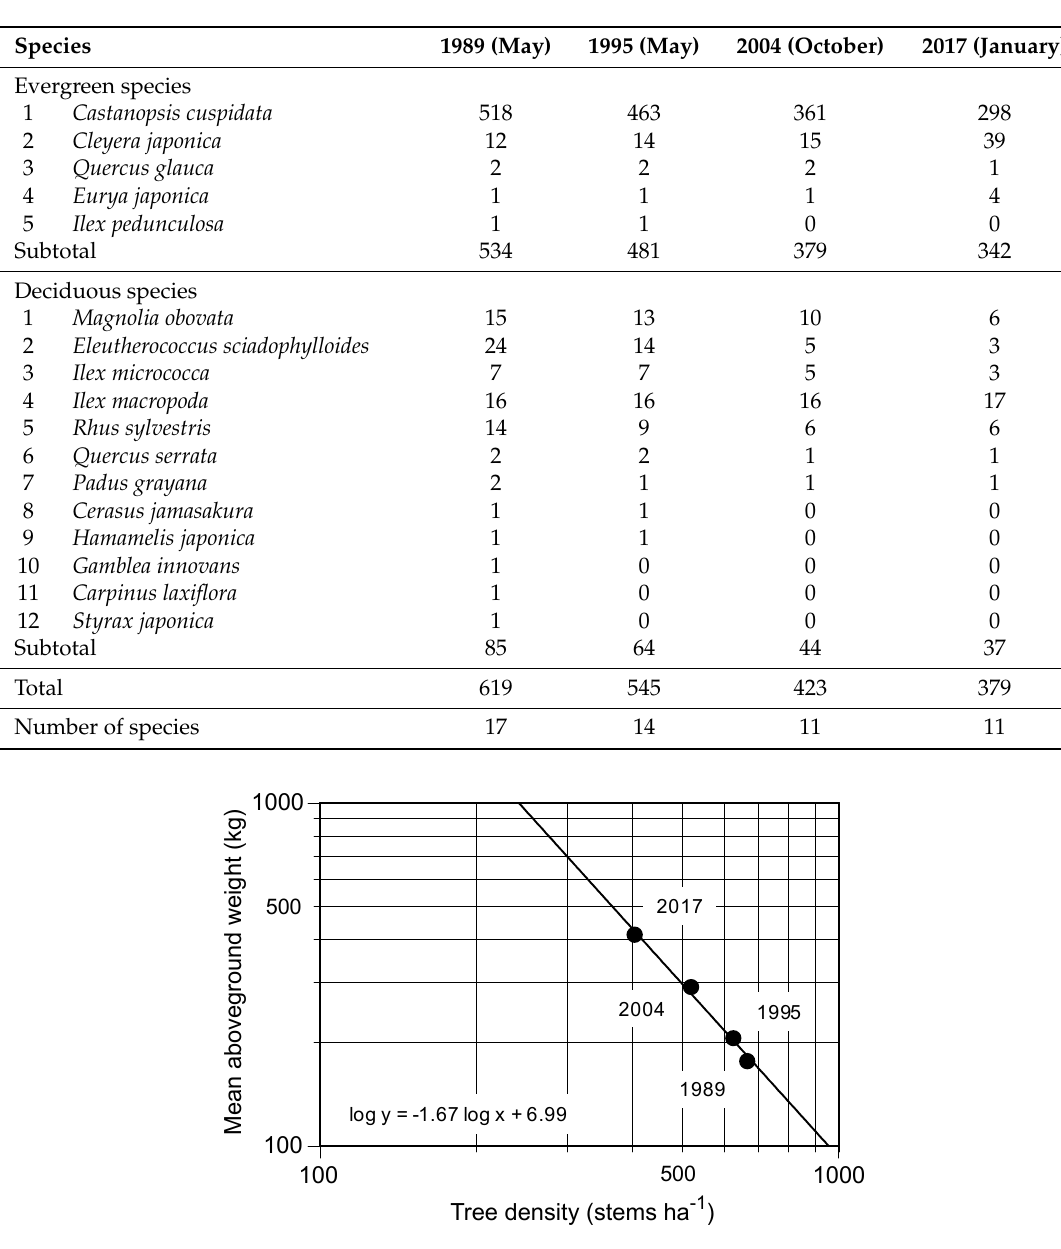
Table 3. Dynamics of species and stems number in the permanent plot (0.7 ha) during the 28-year period (DBH ≥ 10 cm).